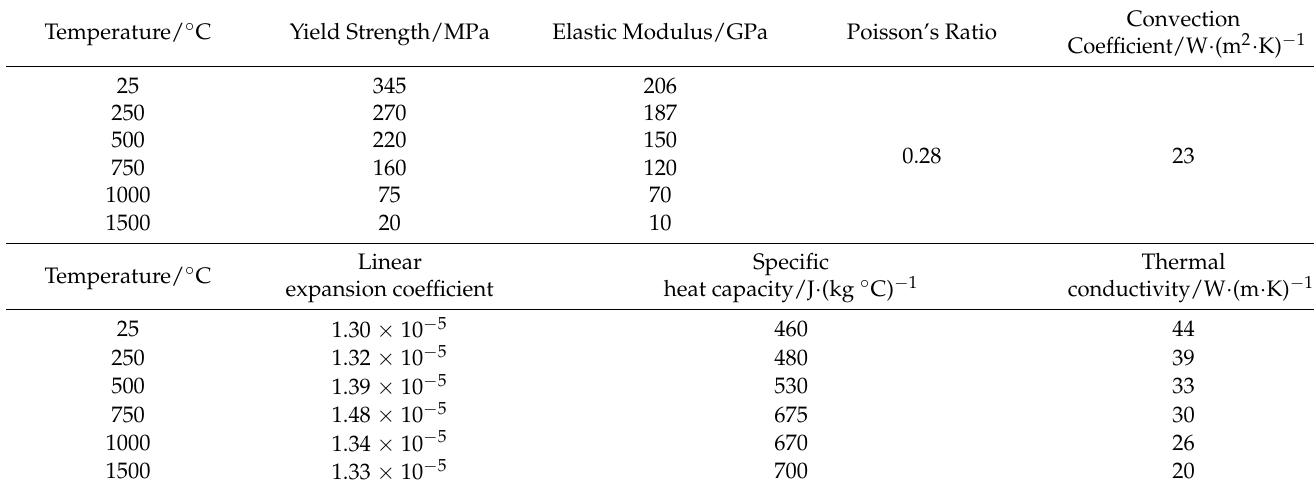
Table 1. Changes in the mechanical properties of the welding base metal at different temperatures